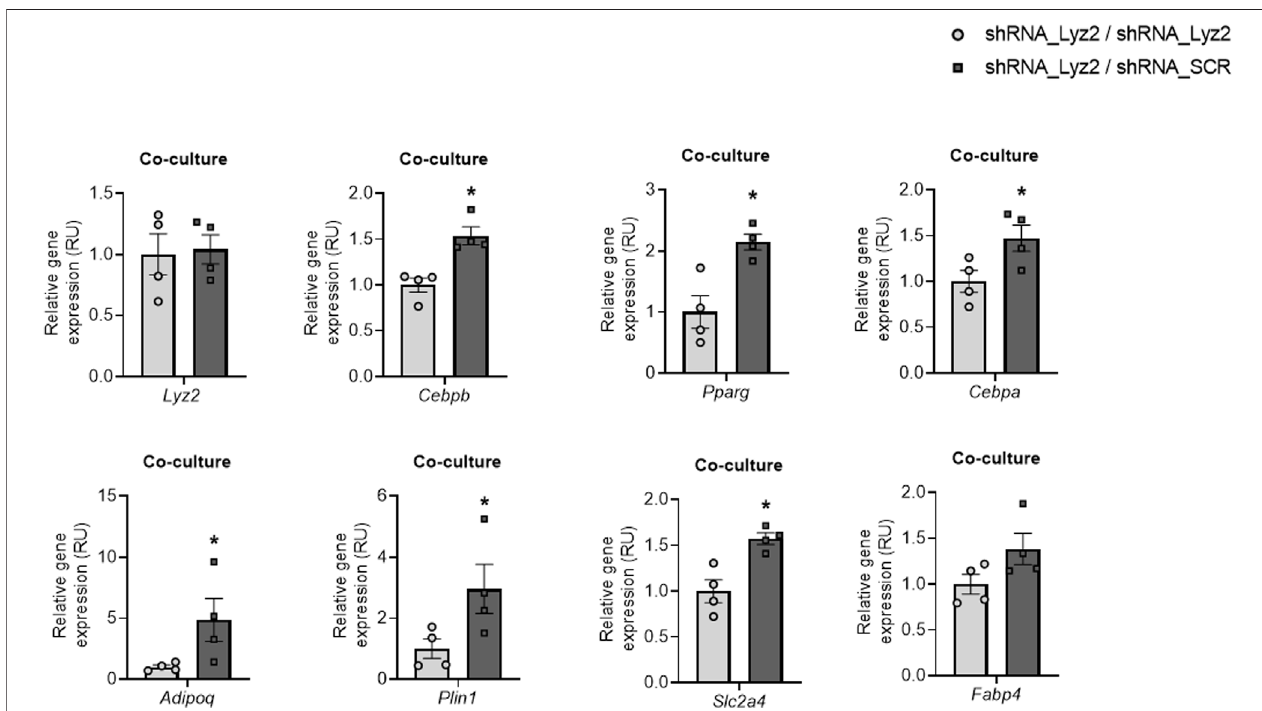
FIGURE 4 | The effect of coculture Lyz2 gene knockdown cells (shRNA_Lyz2) with lysozyme-producing cells (shRNA_SCR) on Lyz2, Cebpb, Pparg, Cebpa, Adipoq, Plin1, Slc2a4 and Fabp4 gene expression at day 8 of adipocyte differentiation. * p < 0.05 compared to shRNA_Lyz2 cells co-cultured with themselves.